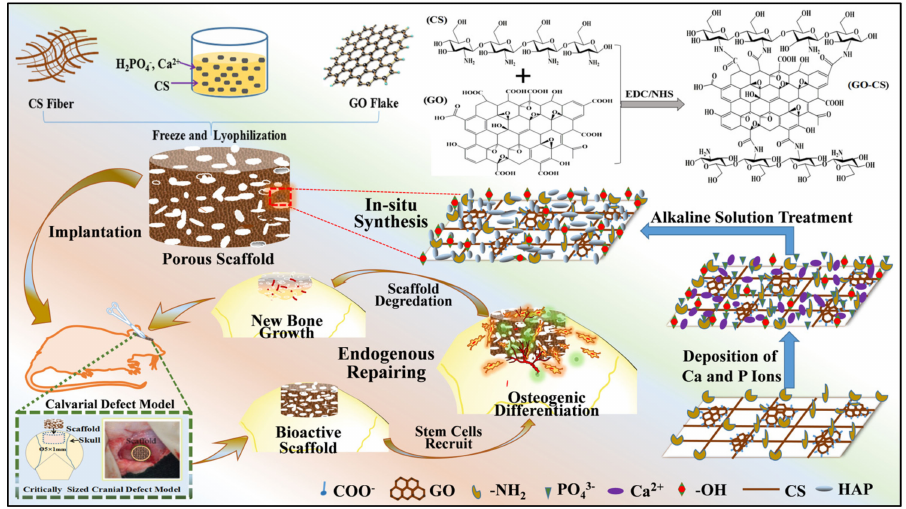
Figure 6. The GO/CS/HAP scaffold prepared by in situ mineralization strategy is used for en- dogenous bone regeneration. Reprinted with permission from ref. [16]. Copyright 2020 Chem. Eng.